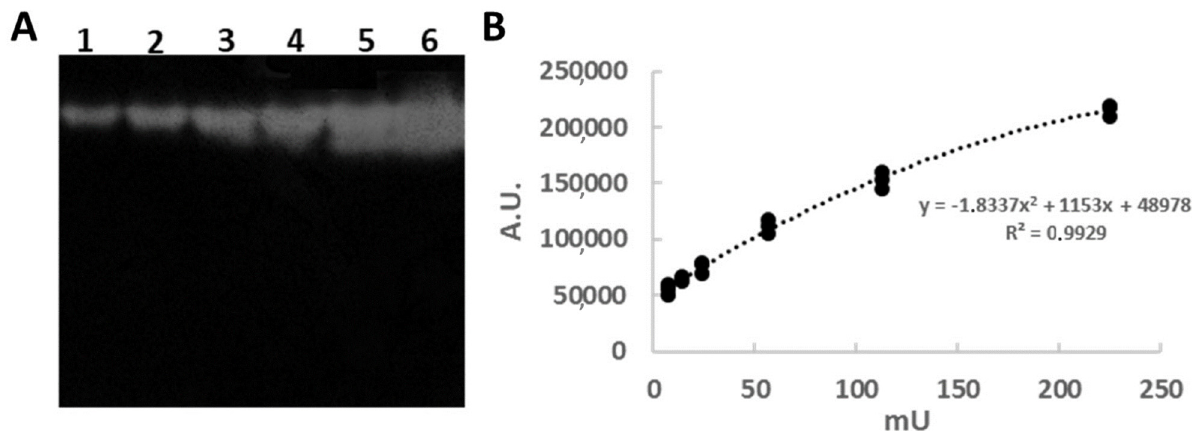
Figure 4. In-gel GPX assay linearity (standard curve). ( A ) Representative picture of a 12% native polyacrylamide gel revealing GPX achromatic bands due to competition for cumene hydroperoxide between the enzyme and Prussian blue. Lane 1–6 represent, respectively, 7.05, 14.1, 23.82, 56.4, 112.5, and 225 milliunits (mU) of standard bovine erythrocyte GPX. ( B ) Dynamic detection range (second-grade polynomial regression). Values of integrated density (arbitrary units) vs. GPX mU obtained from three independent experiments. The polynomial regression allowed a larger dynamic range of quantification.